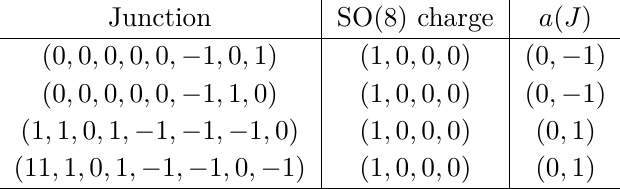
Table 6 . The four junctions with highest weight of 8 c under SO(8)